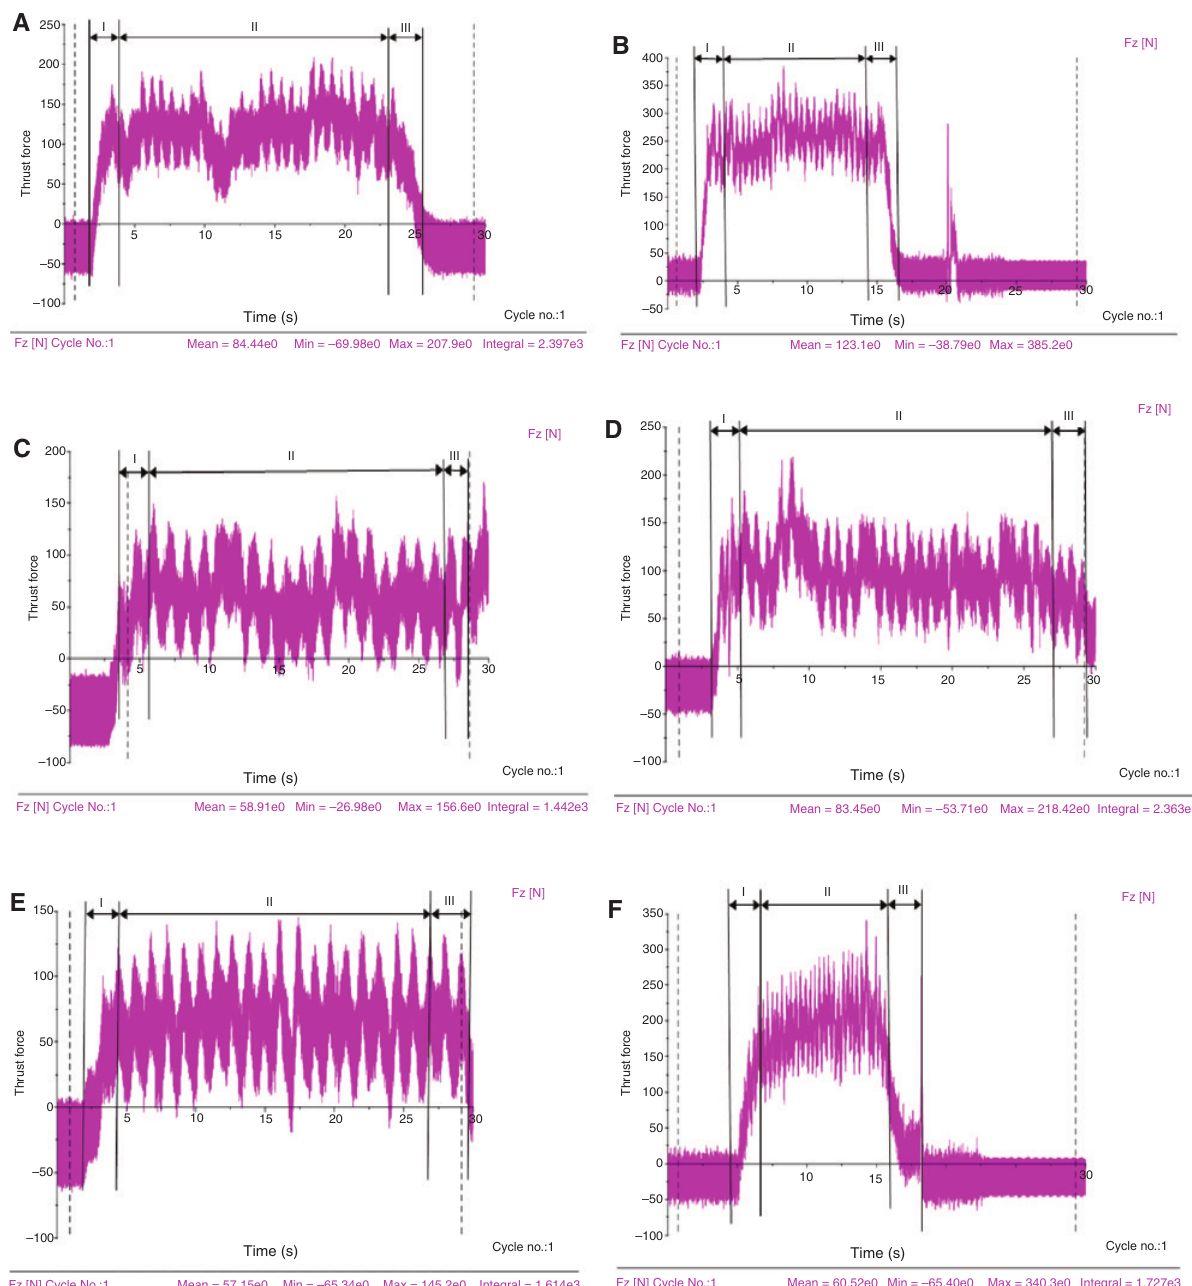
Mean = 57.15e0 Min = –65.34e0 Max = 145.2e0 Integral = 1.614e3